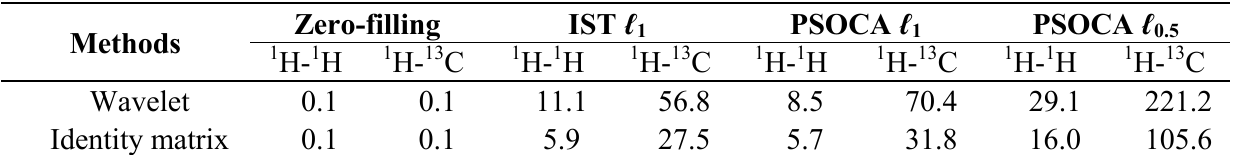
Table 3. Running time for reconstruction of a NMR spectrum (unit: